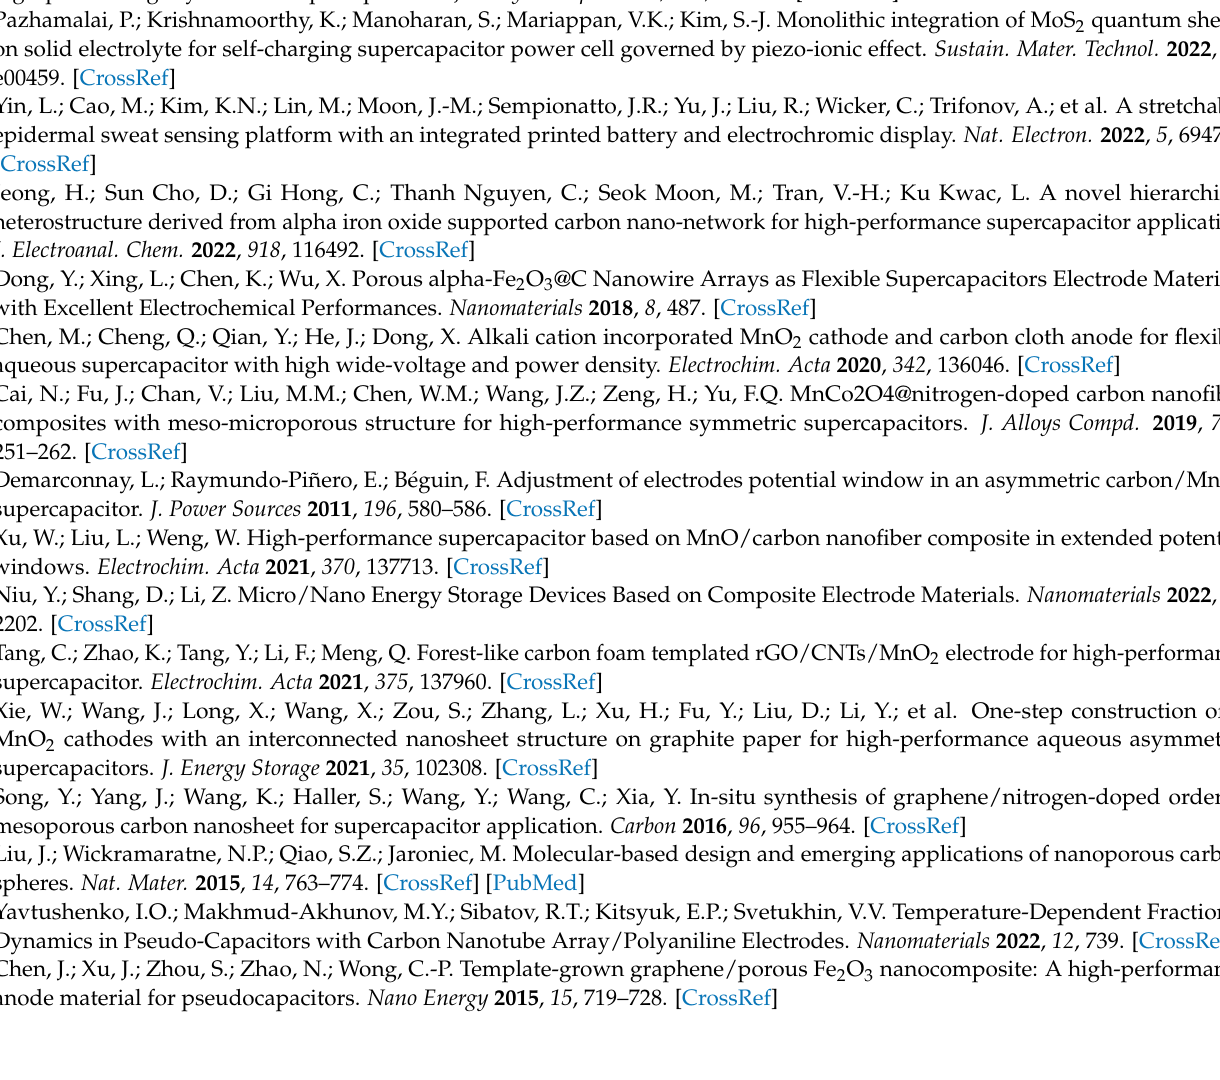
10.3390/nano12213819/s1, Figure S1: High-resolution of XPS spectrum of Fe2p; Figure S2: GCD curves of FPC composites (a) FPC-90, (b) FPC-180, and (c) α -Fe 2 O 3 at different current densities; Figure S3: The charge storage contributions of FPC-90 (a, b, c, d) and FPC-180 (e, f, g, h) at different scan rates; Figure S4: Characterization of MPC cathode material, (a) SEM image, TEM image, XRD pattern, and BET isotherm of MPC samples; Figure S5: Comparative CV curves of MPC and FPC electrodes; Figure S6: Nyquist plot of the ASC device; Table S1: Elemental and proximate analyses of oily sludge; Table S2: Pore structure parameters of samples; Table S3: Specific capacitance of recently published Fe 2 O 3 /Carbon composites; Table S4: Performance of Fe 2 O 3 -based electrodes